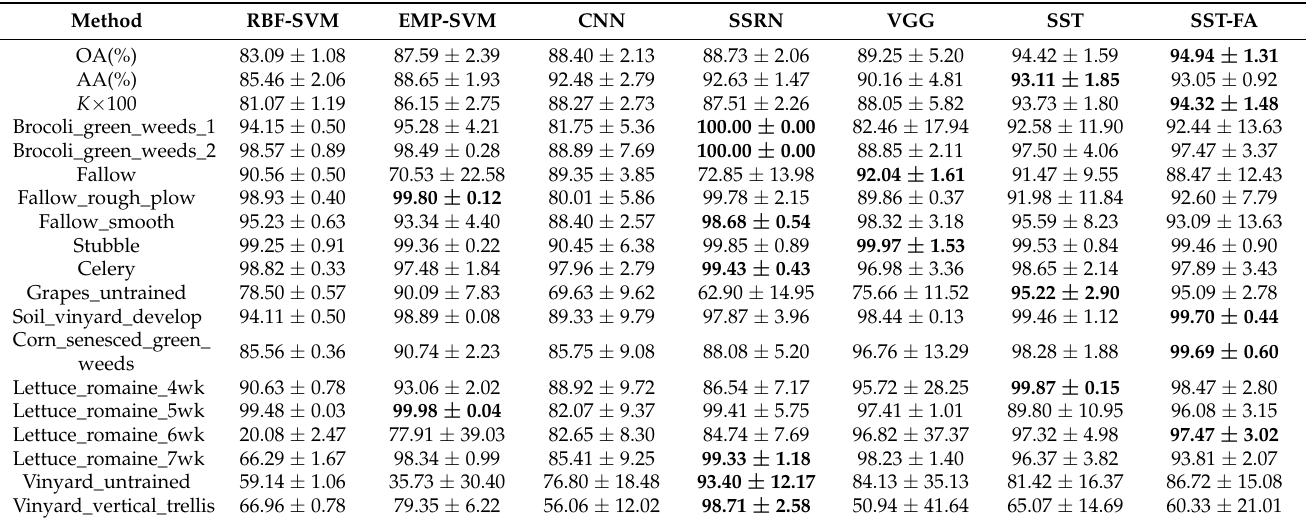
Table 2. Test accuracy with different preprocessing methods on the Salinas dataset.